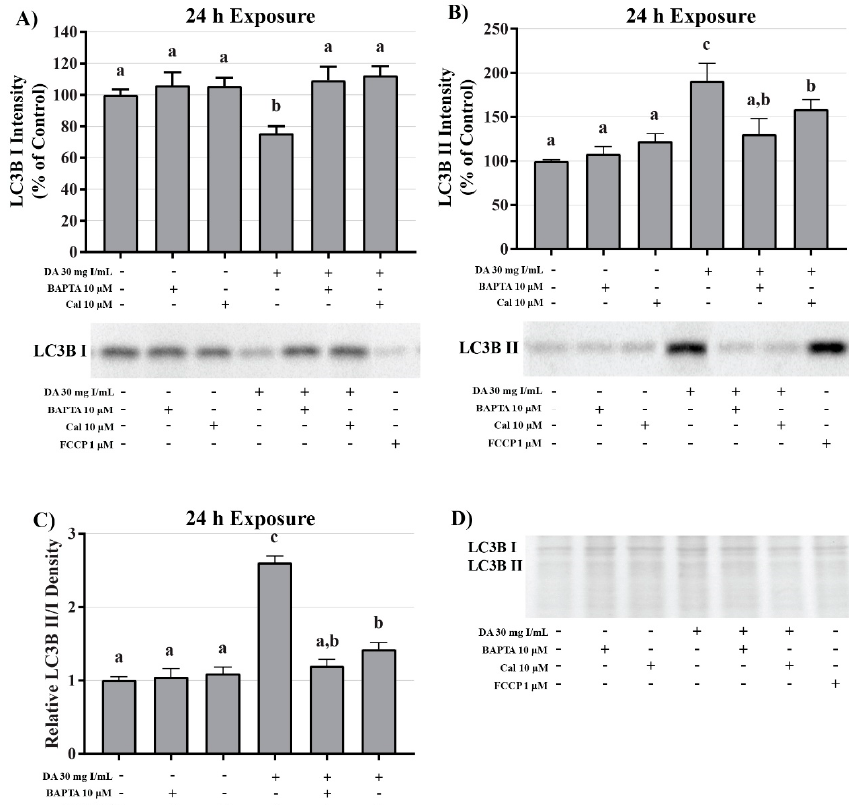
Figure 20. Effects of BAPTA-AM or calpeptin pretreatment on light chain (LC)3B expression in HK-2 cells. Pretreating HK-2 cells with BAPTA-AM or calpeptin attenuated DA-induced conversion of LC3BI to LC3BII. Representative blots and cumulative densitometry included for LC3BI ( A ), LC3BII ( B ), and LC3BII / LC3B I ratio ( C ) following 24 h exposure to DA. Protein loading stain depicted for 40 µ g loaded pin ( D ). Positive control for LC3B conversion was FCCP (oxidative phosphorylation uncoupling agent). Di ff erent superscripts (a–c) indicate a statistical di ff erence ( p < 0.05) between group. Values represent mean ± SEM for three independent experiments of two biological